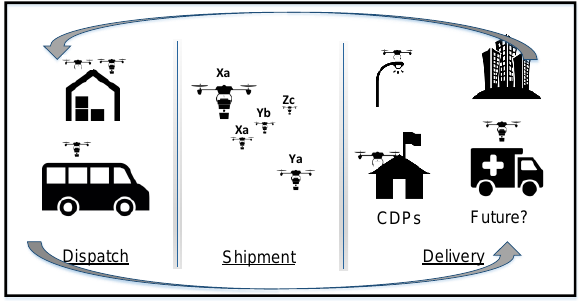
Figure 3 Parcel delivery using UASs in an urban environment During dispatch the relevant parcel is loaded to an UAS